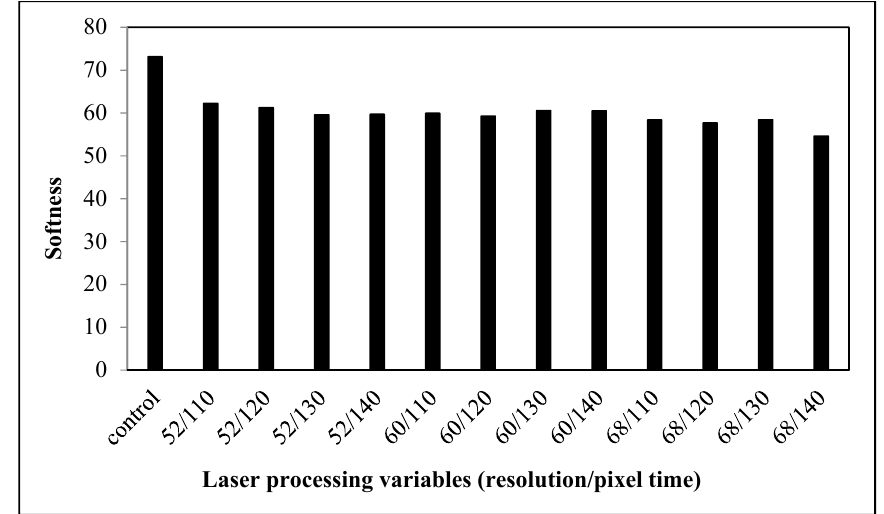
Figure 10. Relationship between laser processing variables and the softness of cotton/polyester blended fabric.